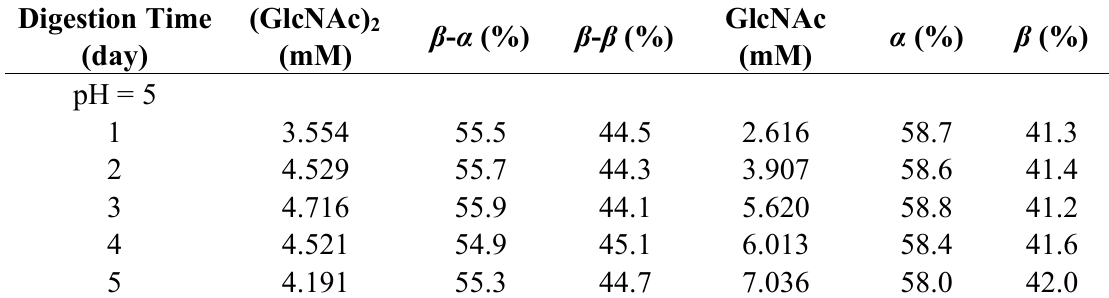
by chitinase from Streptomyces griseus 2